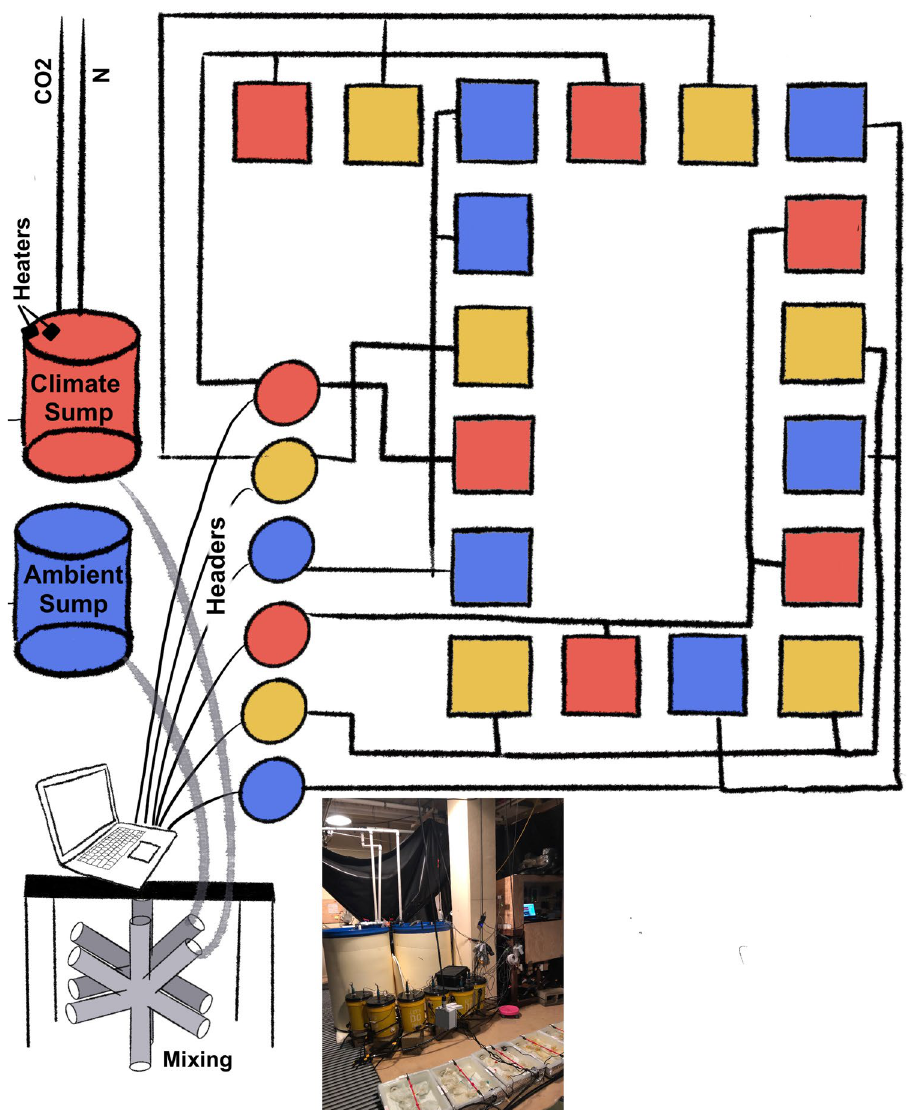
Figure 4. Conceptual figure illustrating the flow-through experimental mesocosm. Blue represents the year 2020 treatment, yellow represents year 2050, and red represents year 2100. The ambient and climate change sump tank water (cylinders) is mixed as it flows to the header tanks (circles) to attain the setpoints for each treatment. There are two replicate header tanks for each treatment and each header tank supplies water to three replicate aquaria (squares), for a total of six replicate aquaria for each